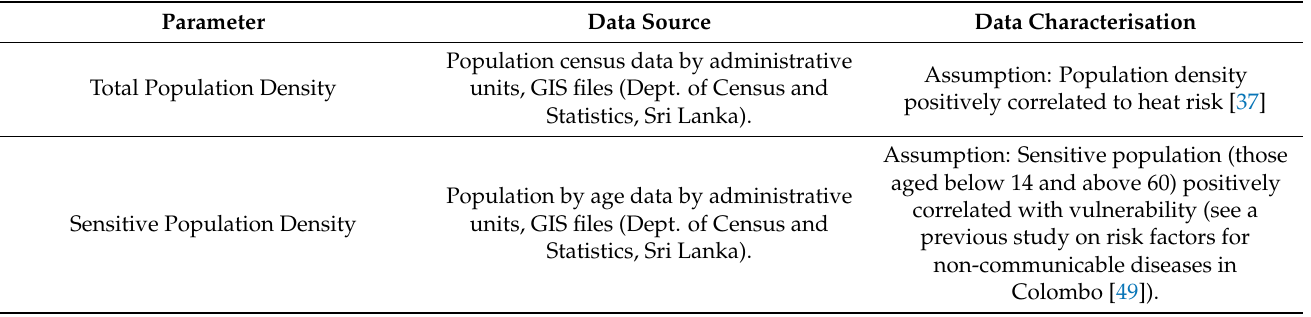
Table 2. Socioeconomic data, characterisation, and